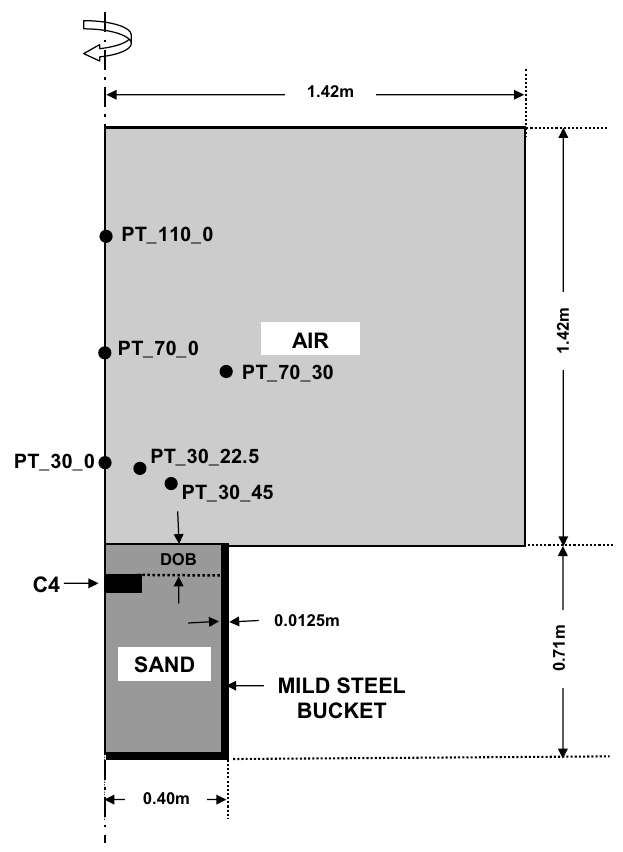
Fig. 4. A simple schematic of the experimental setup used in Ref. [2] to study the effect of explosion of a shallow-buried mine. The designations and the position coordinates of the six transducers are given in Table 2. The first number in the Pressure Transducer (PT) designation represents the distance in centimeters of the transducer from the origin of the coordinate system (defined below), while the second number represents the angular relation in degrees between the position vector of the pressure transducer and the axis of symmetry. The location of the six pressure transducers is also shown in Fig. 4. To be consistent with the definition of coordinate system for the 2D axi-symmetric problem used in AUTODYN [10], the y coordinates are measured in the radial direction from the centerline of the barrel, while the x coordinates are measured along the axis of symmetry, with x = 0 corresponding to the sand surface and x < 0 denoting the air region above the